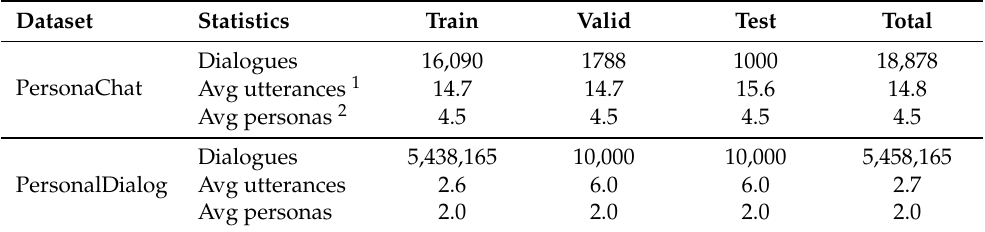
Table 2. The statistical results of persona-dense and persona-sparse open